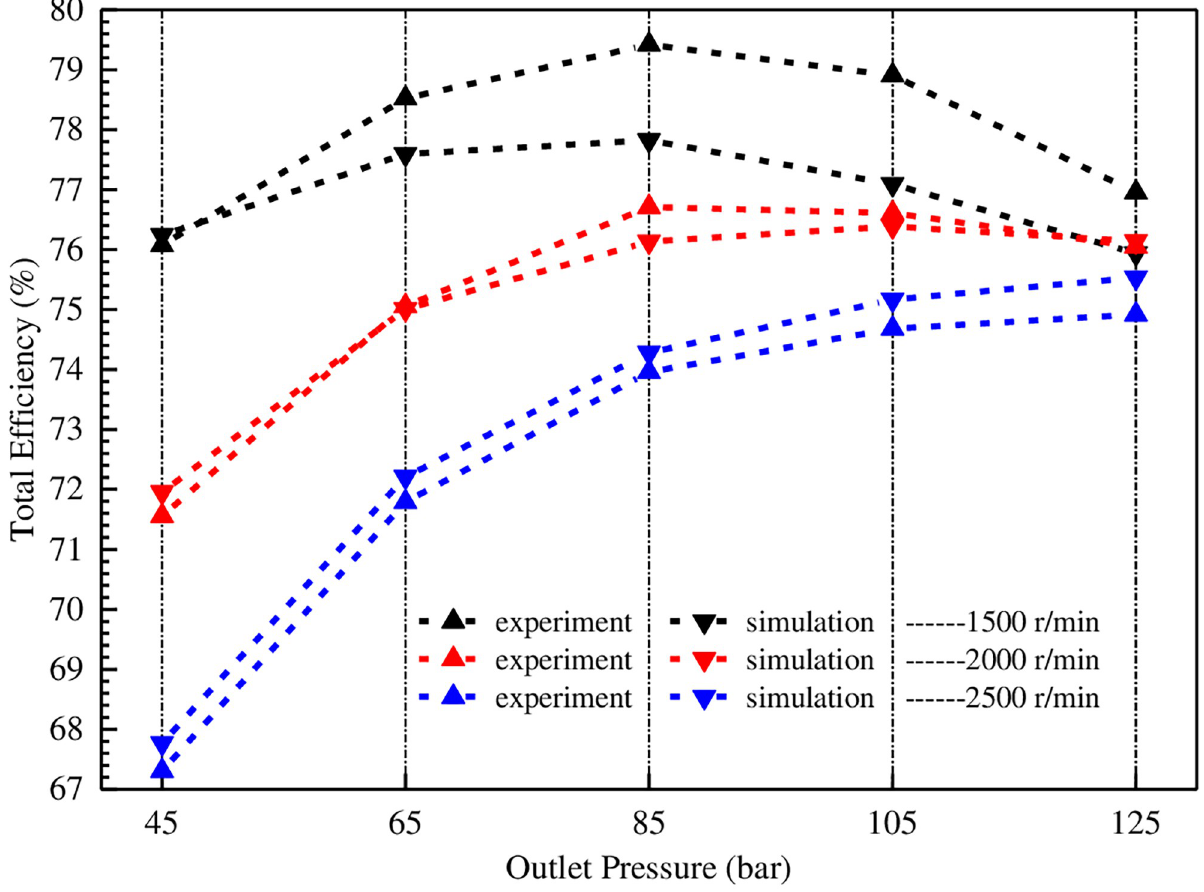
Fig 23. Comparison of total efficiency between experiment and simulation under variable working